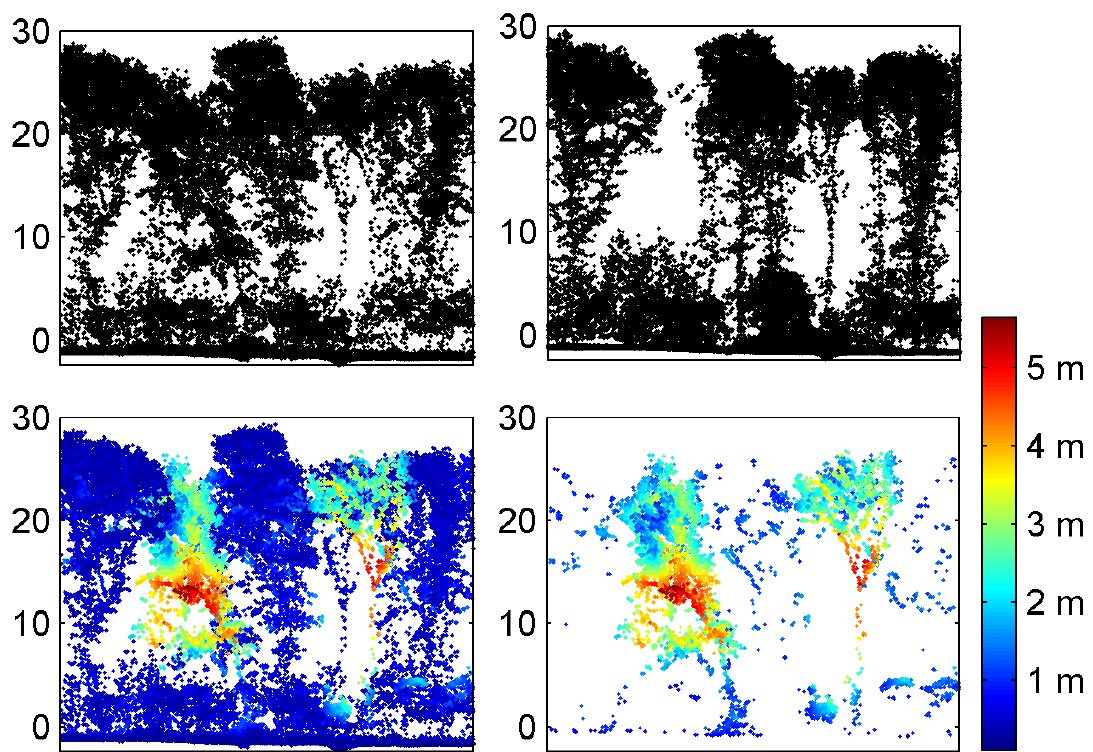
Figure 4: Side view of a small forest patch in 2008 (top left) and 2012 (top right) where two trees have been removed. The robust cloud to cloud distance calculated with k = 10 is given in the bottom left and the points identified as change in the bottom right image using a global threshold T g of 0.5